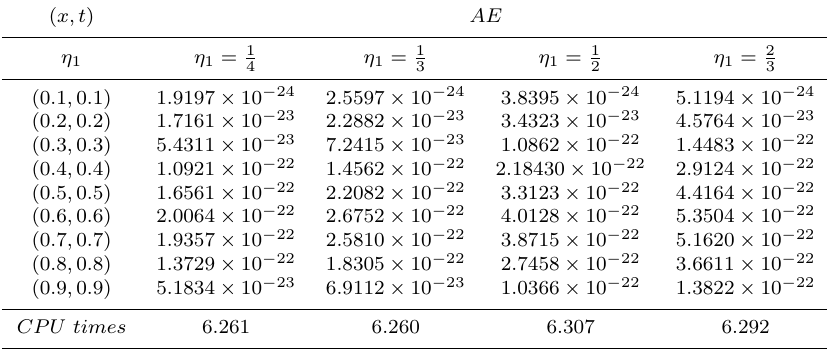
Table 1. The comparison of the absolute error(AE) obtained by our numerical method at some selected points with m = m ′ = 1, M = M ′ = 64, η = 1 and different values for η 1 in Example 1.